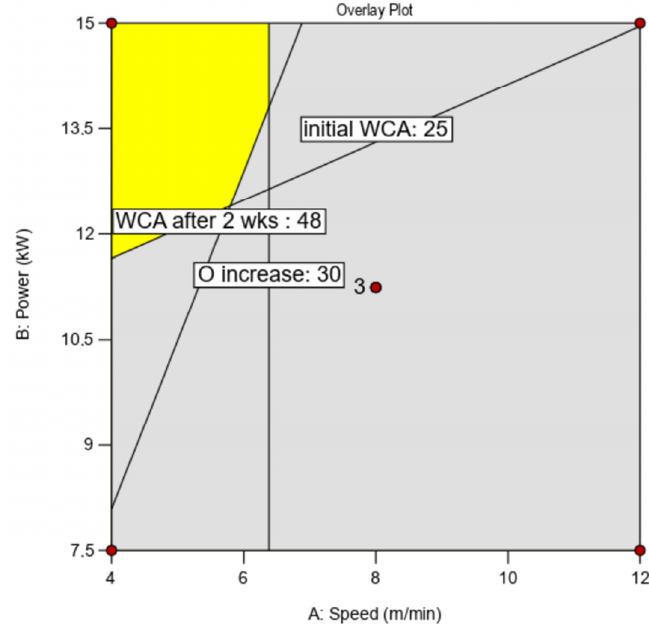
Figure 3. Overlay plots of power (B) versus speed (A). Table 4. Relative composition (in percentages) of the different chemical groups detected with the deconvolution of the C 1s and O 1s spectra for the plasma-treated